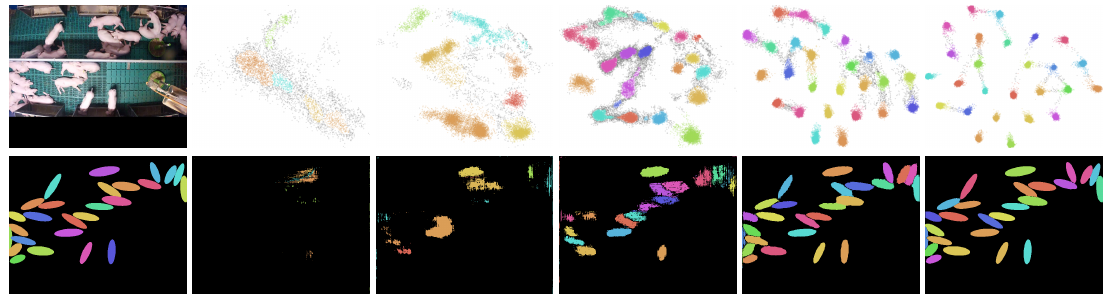
Figure 6. Results of the combined segmentation. On the left the original input image and below the ground truth label are shown. The top row depicts a two-dimensional embedding space. The bottom row depicts the corresponding binary segmentation and the assignment of the clusters. The snapshots are created after 1, 2, 3, 10 and 80 gradient updates. The network was trained solely on the shown input image to generate the results shown here for illustration purposes.